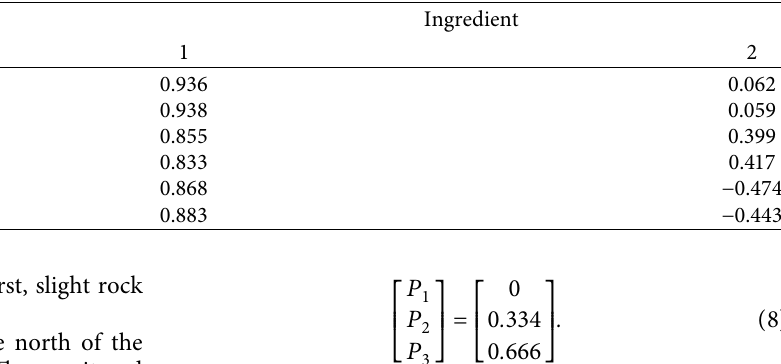
Table 3: Ingredient matrix for the microseismic